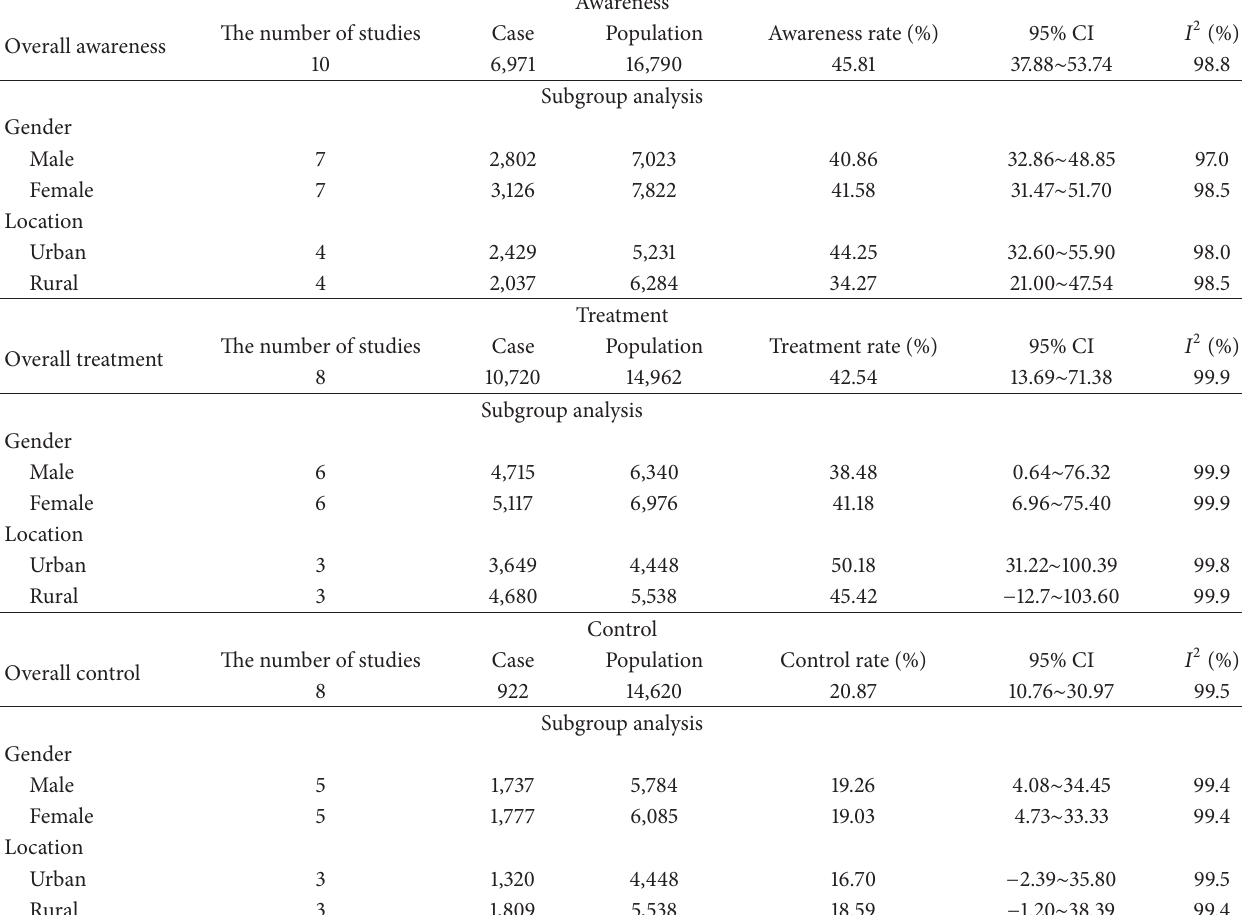
Table 3: Overall awareness, treatment, and control of diabetes and subgroup